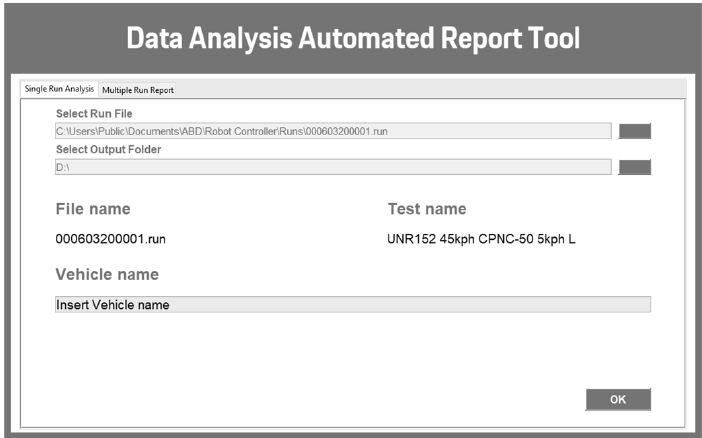
Figure 5. Single-run analysis